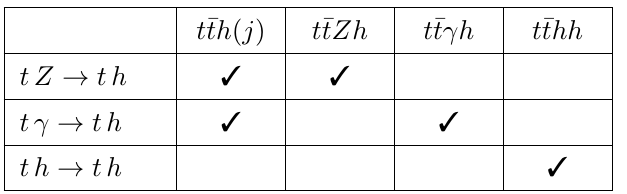
Table 8. The set of two-top 2 2 scattering amplitudes with Higgs bosons considered in this ! work mapped to the collider processes in which they are embedded.